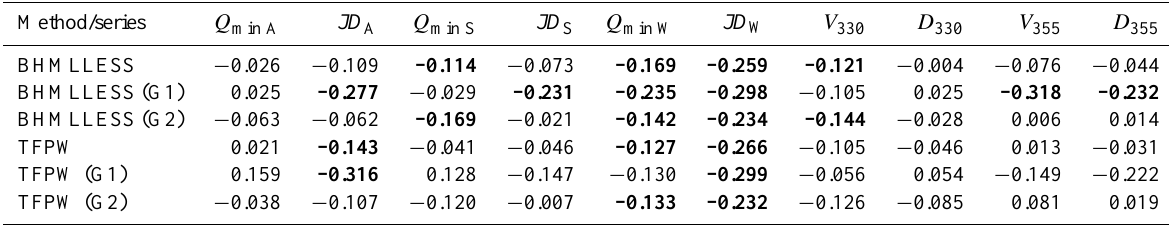
Table 2. Kendall’s rank correlations between FARIMA(0, d , 0) Hurst exponent estimates and p values of selected trend tests for all stations together and separately for mountain (G1) and lowland (G2) water-gauging stations as regards low flows in Czechia during the period 1961–2005. For series designations see Sect. 2.